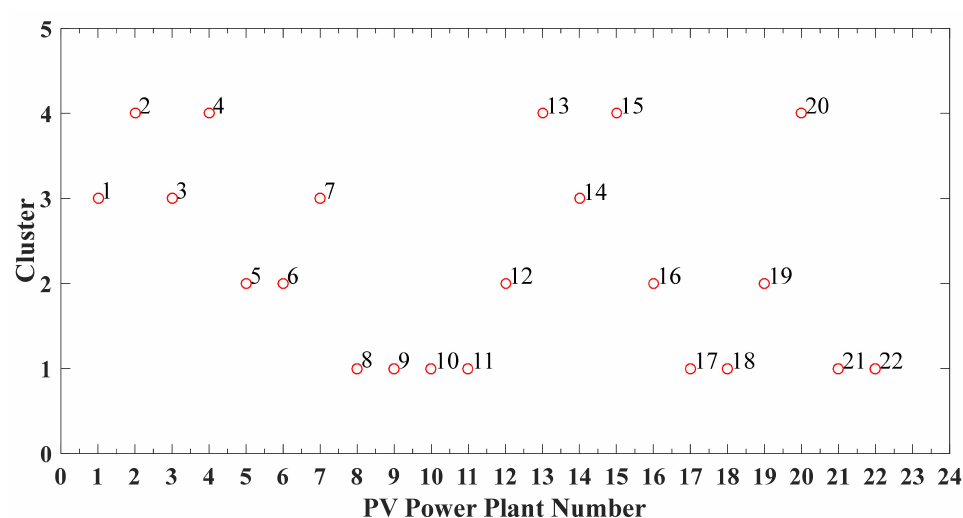
Figure 8. Cluster result of sub-region